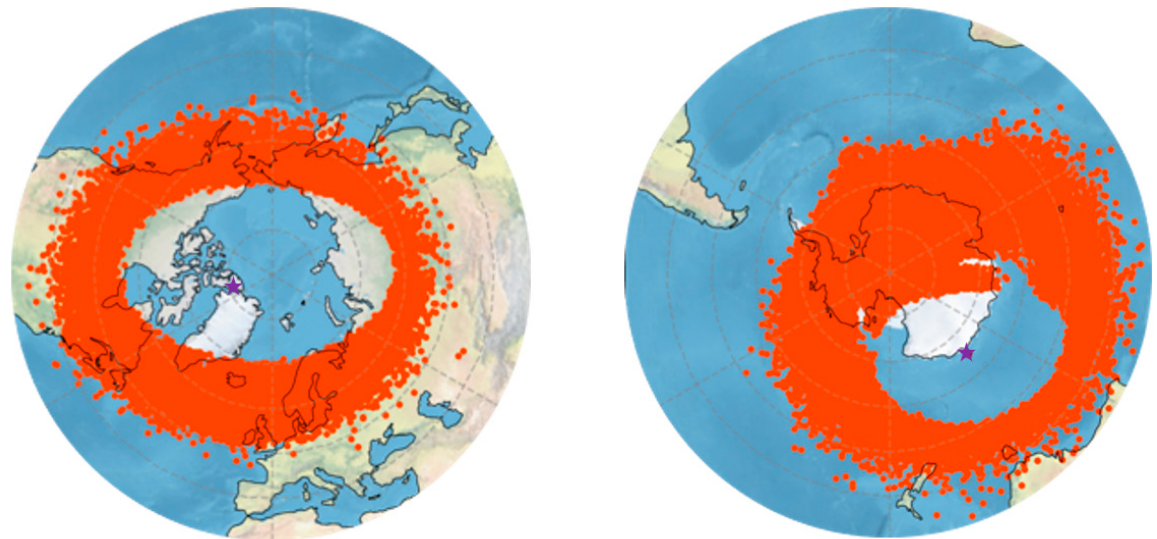
Figure 5. Polar view of geographic locations of trough minimum locations (red dots) for the northern ( left plot ) and southern ( right plot ) hemispheres. Purple stars show the locations of the geomagnetic pole for each hemisphere.